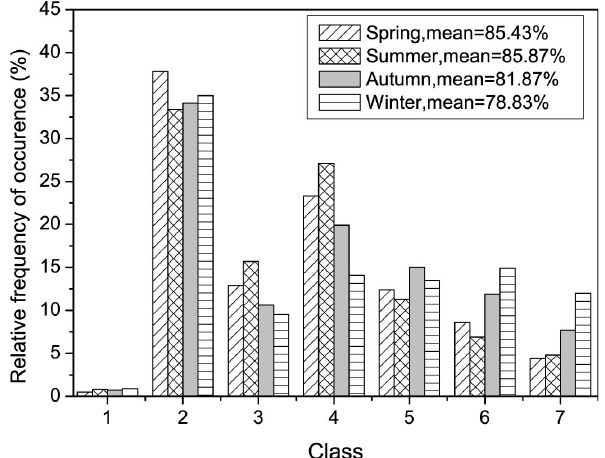
Fig. 2. The seasonal classified distribution of the flux contribution calculated at SACOL site. Class 1: the flux contributions in per- centage from the target zone is 100%; class 2: 95–99.9%; class 3: 90–94.9%; class 4: 80–89.9%; class 5: 70–79.9%; class 6: 40– 69.9%; class 7: <